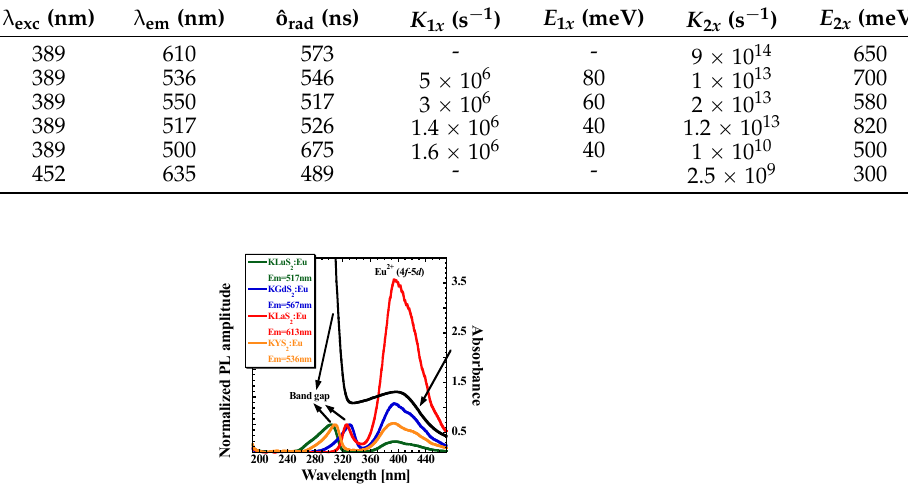
Figure 5. RT PLE spectra of KLnS 2 :Eu (0.05%) samples (Ln = Lu, Y, Gd, La) and RT absorption spectra of KLuS 2 :Eu (2% Eu, thickness 0.2 mm); data of KLuS 2 :Eu after [27].